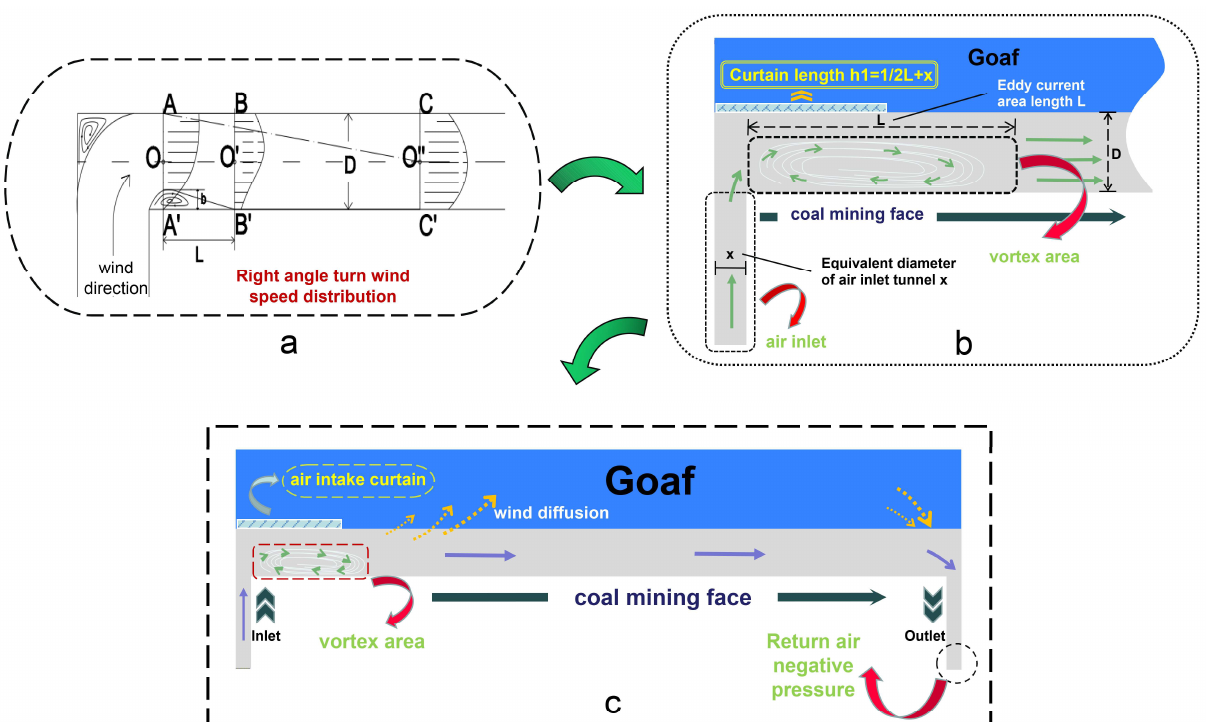
Figure 2. Schematic diagram of wind flow. ( a ) Wind speed distribution at right-angle turns; ( b ) Analysis of the air inlet air curtain; ( c ) Analysis of the wind flow state of the working face.